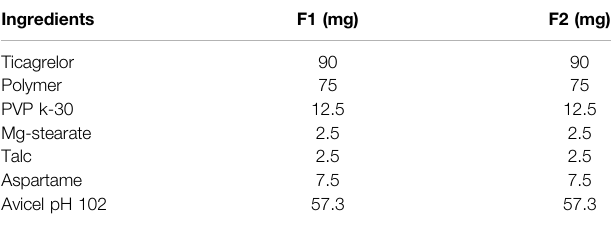
TABLE 1 | Composition of modi fi ed release tablets of